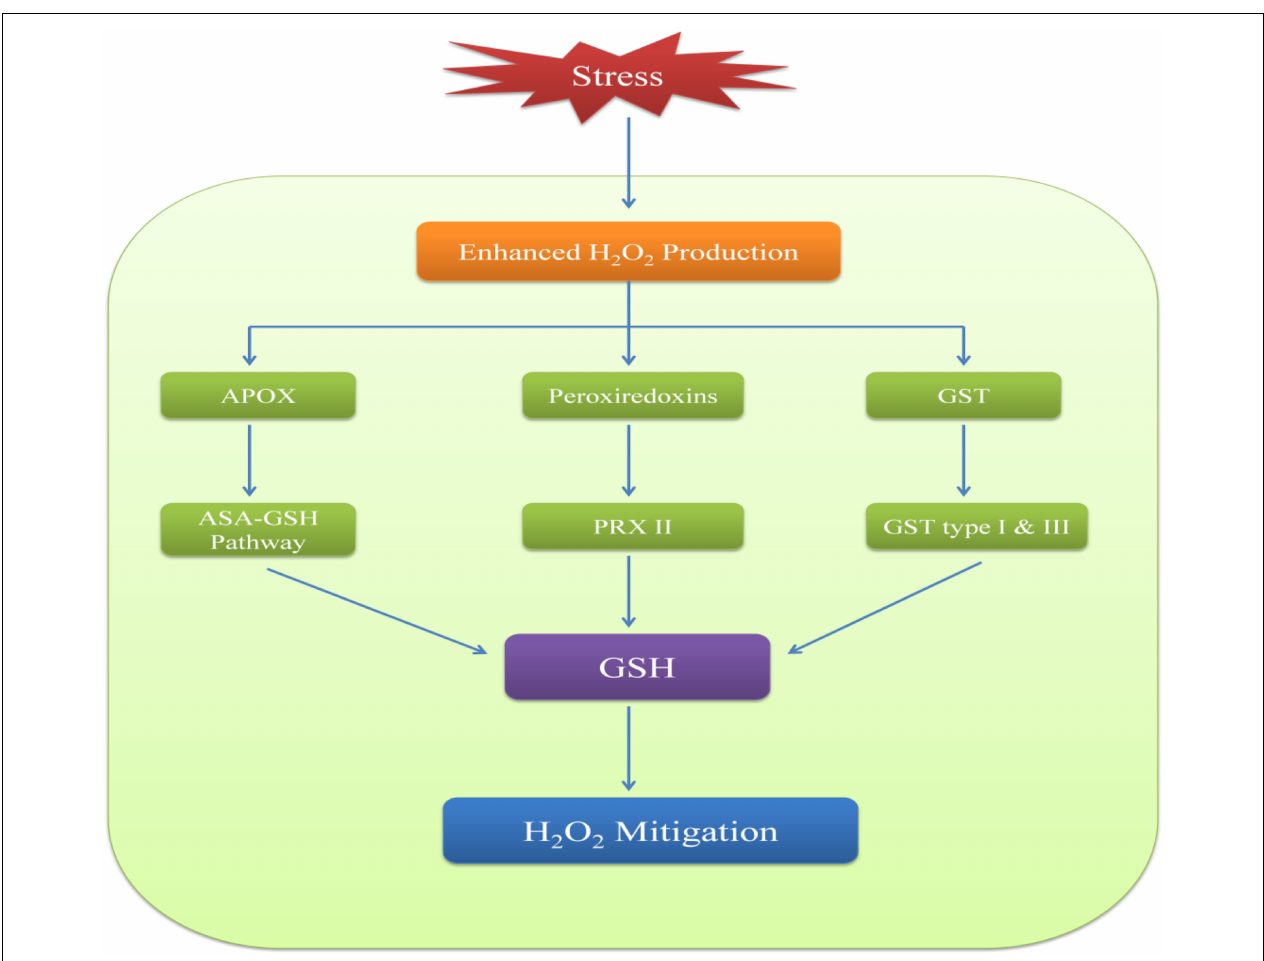
FIGURE 3 | Role of GSH in maintaining H 2 O 2 homeostasis via APOX, peroxiredoxins and